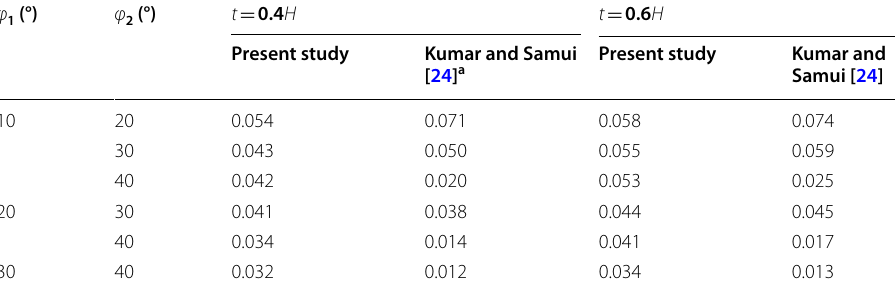
Table 7 A comparison of F obtained by Kumar and Samui [24] with the present solutions s considering β 45° and c c 1 = =